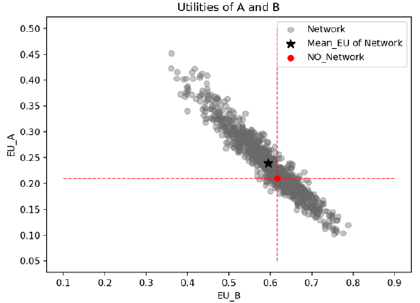
Figure 5. Expected utilities of firms in the cases of agents with and without connections.